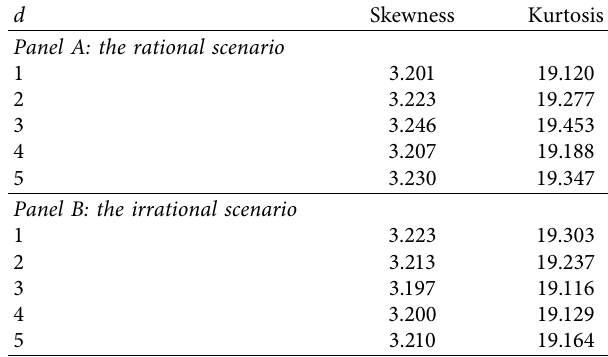
Table 5: Skewness and kurtosis of returns. Note: This table reports the outcomes of reproducing fat-tailed returns using the param- eters from Zhu et al. [35] and Amilon [82]. The skewness and kurtosis of returns are calculated, respectively, in rational and irrational scenarios. d suggests the degree of behavioral hesitation and decision rigidity of the anxious